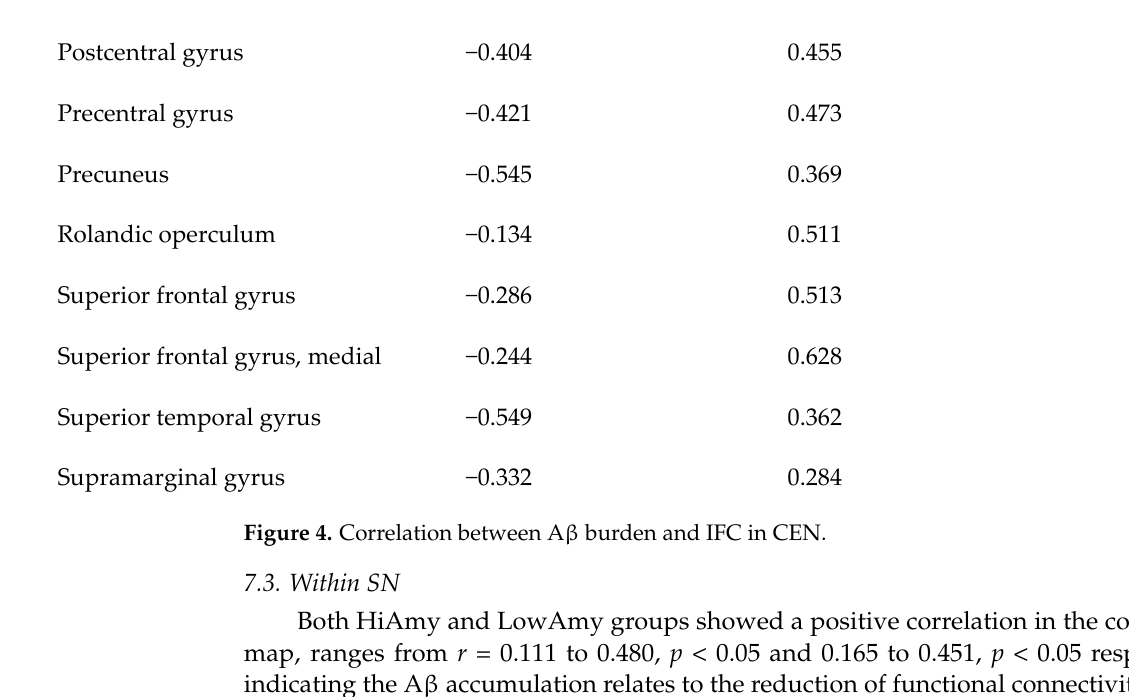
Figure 4. Correlation between A β burden and IFC in CEN.